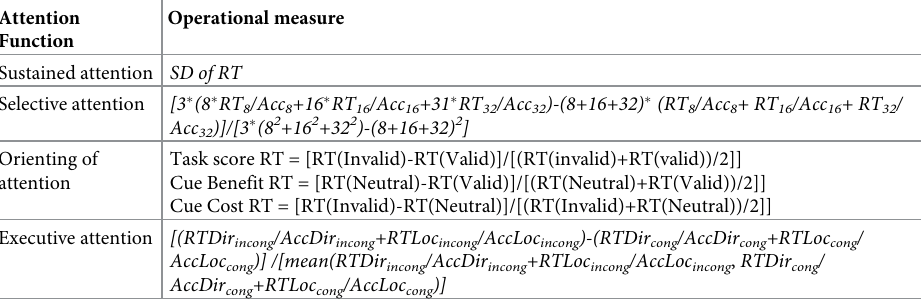
Table 1. Calculation of neuropsychological